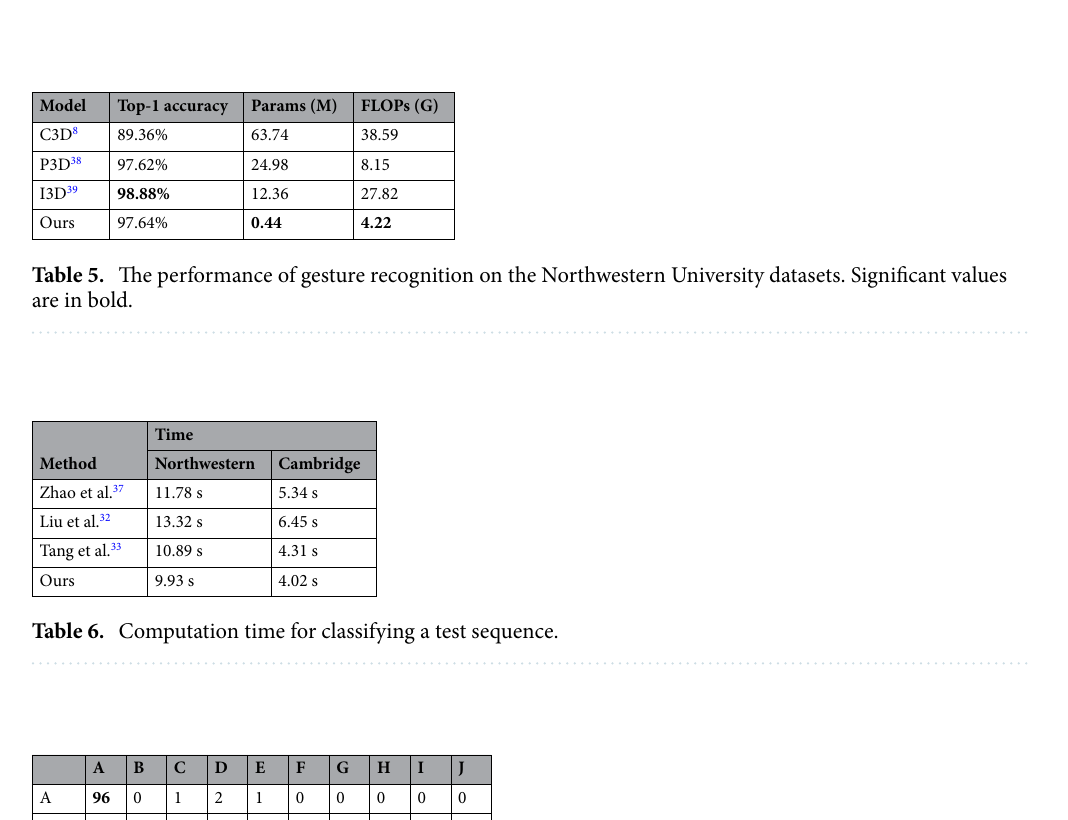
Table 4. Compares our method with state-of-the-art methods on the Cambridge datasets. Significant values are in bold.